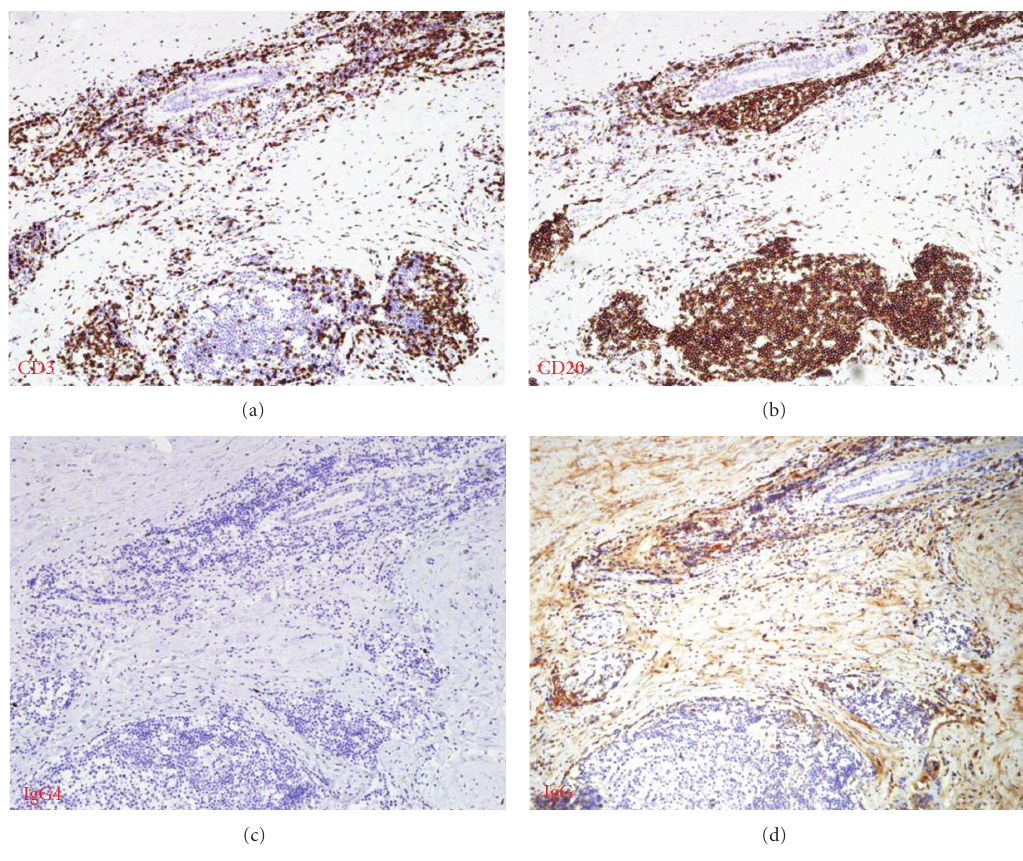
Figure 6: Lymphocyte markers by immunostaining. Infiltrating lymphocytes consisted more of CD20-positive cells than CD3-positive cells. IgG4-positive lymphocytes were rarely found compared with IgG positive cells.